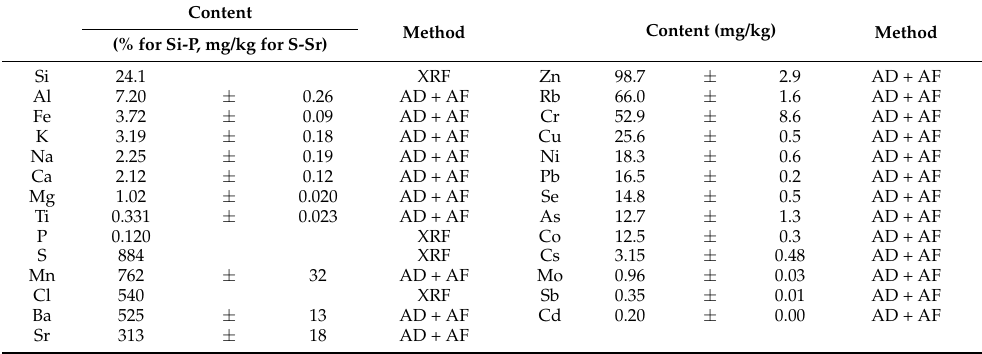
Table 1. Elemental composition of sandy